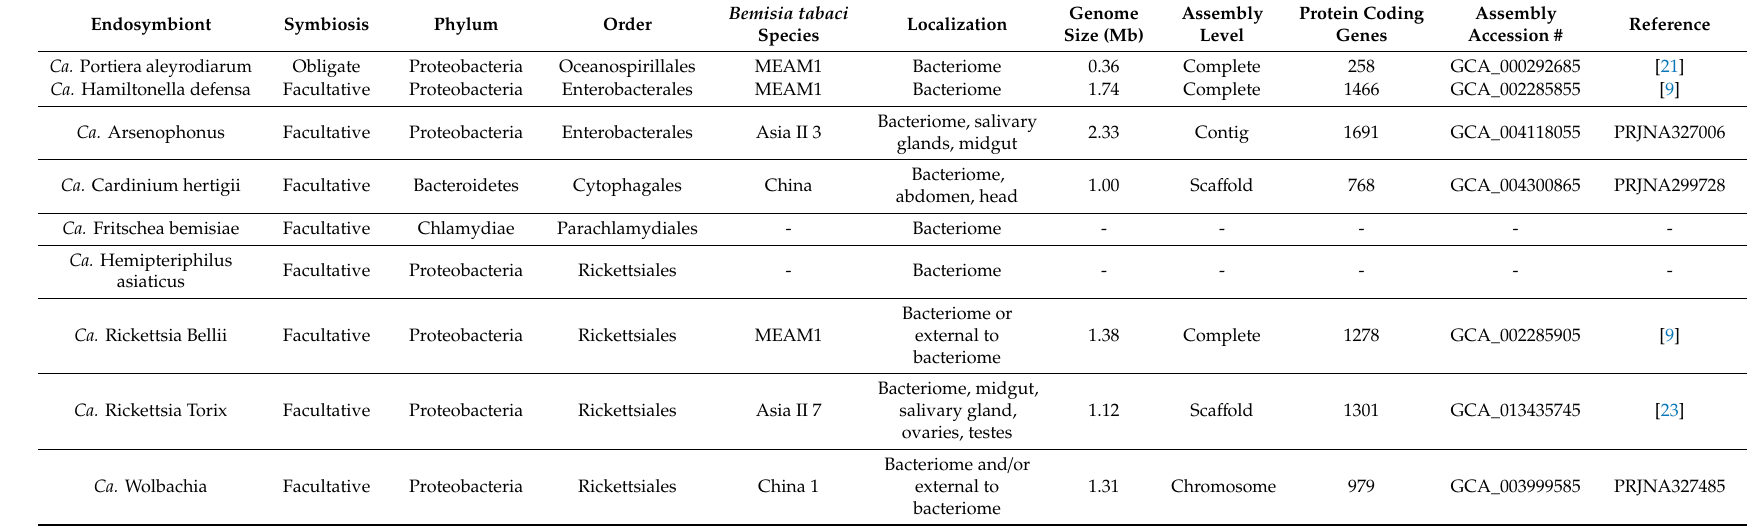
Table 1. Taxonomic, biological, and genomic characteristics of the primary and secondary endosymbionts of cryptic Bemisia tabaci . Genome information was obtained from NCBI (https: // www.ncbi.nlm.nih.gov / ) from the earliest and most complete genome assembly for each endosymbiont where available. When the sequence publication reference was not given, the BioProject accession number was